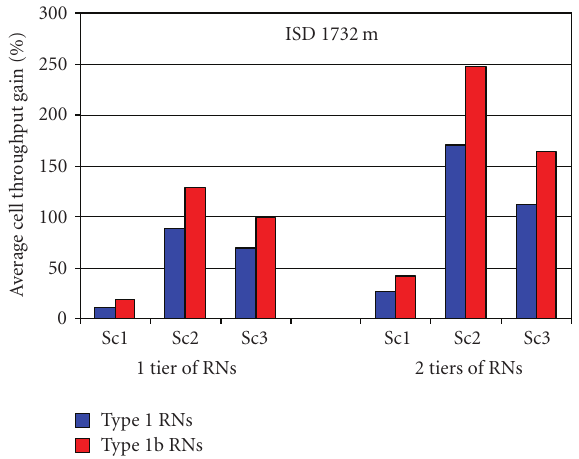
Figure 8: Average cell throughput gains in RN deployments, ISD 1732